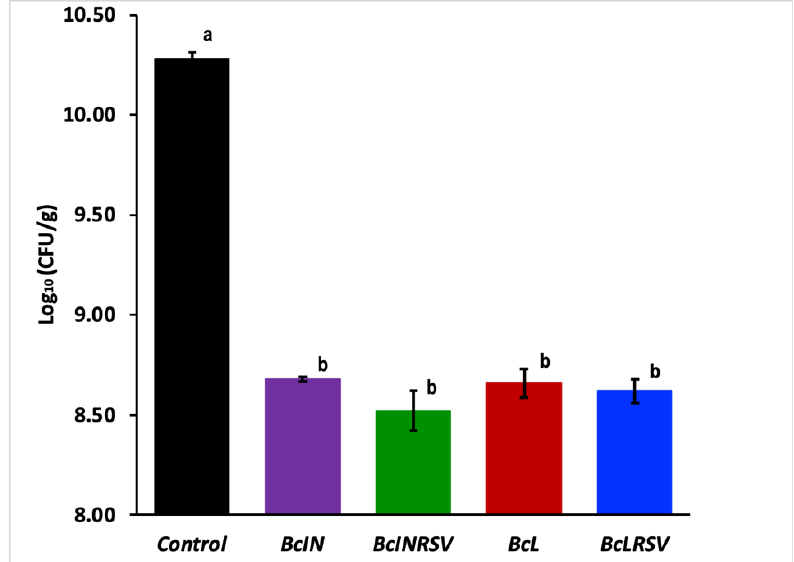
Figure 1. Culturability of B. clausii (control) spray-dried in inulin and lactose matrices without resveratrol ( Bc IN and Bc L) and with resveratrol ( Bc INRSV, and Bc LRSV), a and b are the parameters of the Tukey’s honestly significant difference (HSD) test.